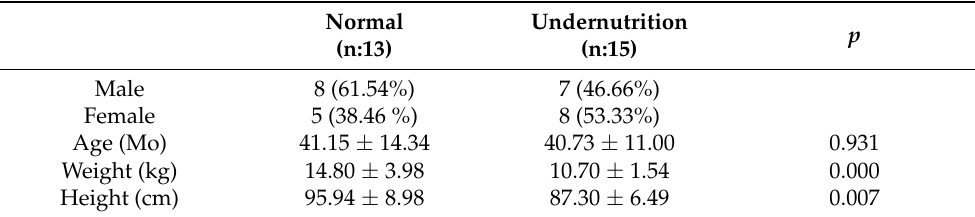
Table 1. Participant characteristics of the